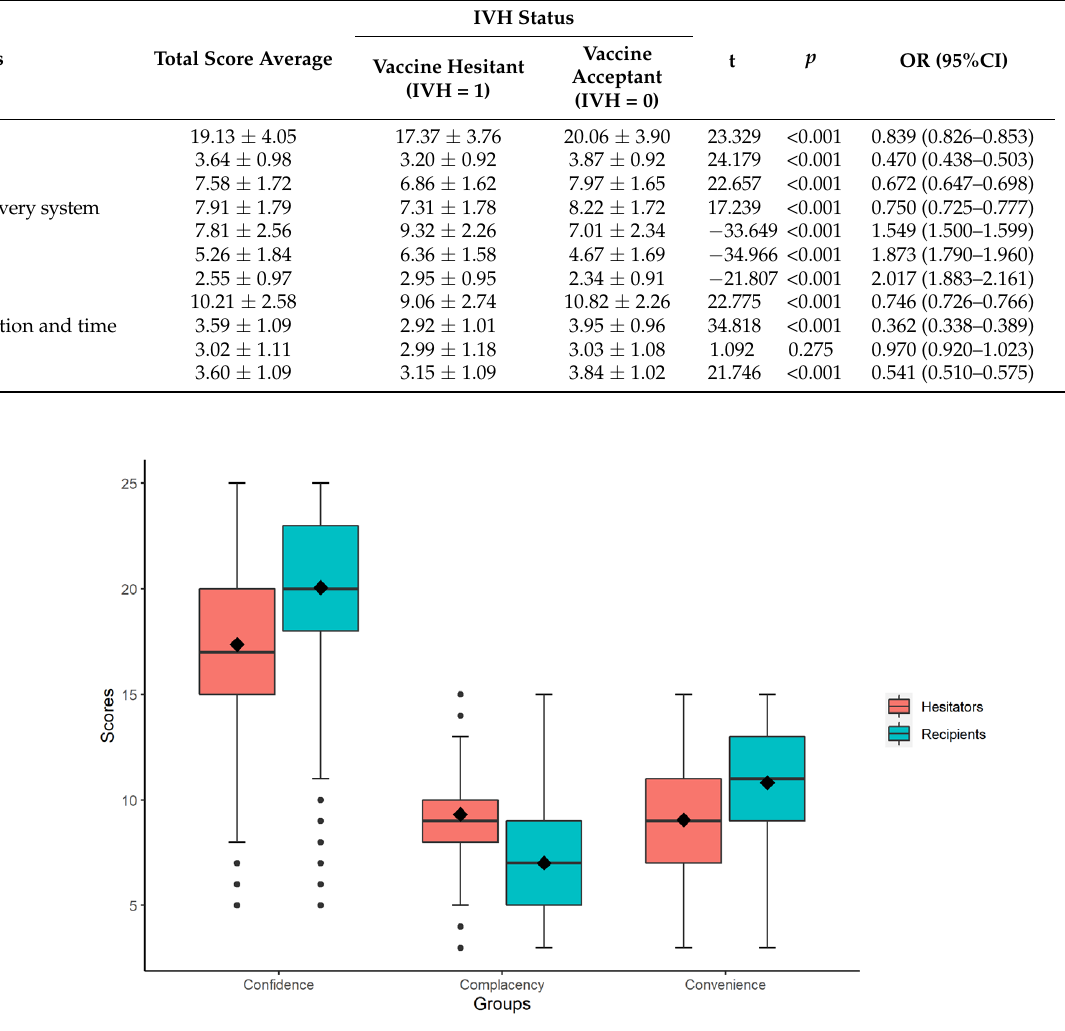
Table 2. Comparison of the scores of each dimension of the “3C” model for different IVH groupings.